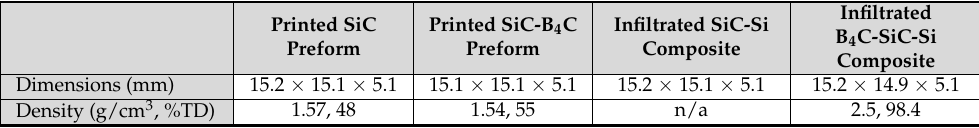
Figure 2. Macro images of ( A ) as-printed SiC preform, ( B ) a SiC preform infiltrated with Si, ( C ) a SiC-B 4 C preform, and ( D ) a SiC-B 4 C preform infiltrated with Si. Table 2. Dimensions and densities of the preforms and